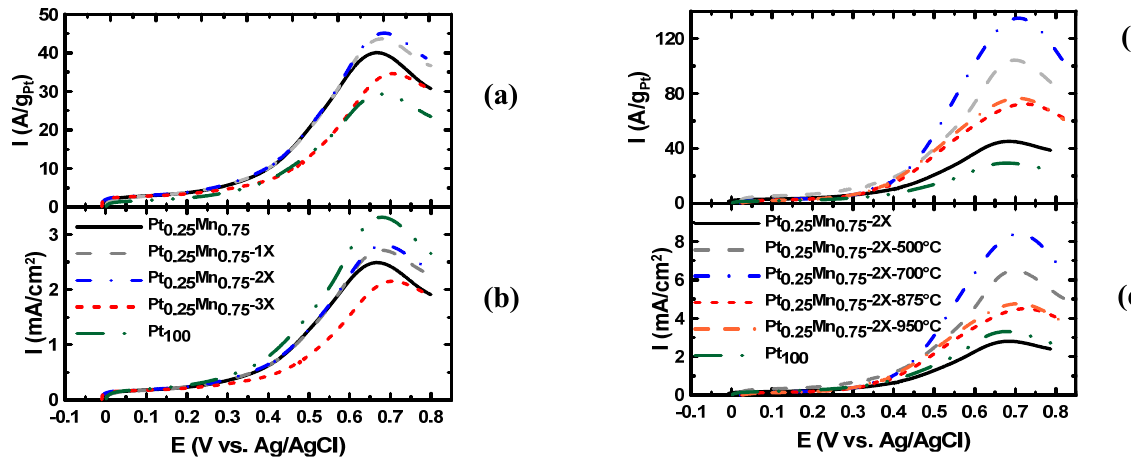
Figure 11. Linear sweep voltammetry (LSV) in the 0.5 M H 2 SO 4 + 0.1 M ethanol solution at a scan rate of 20 mV/s for: ( a ) the samples prepared with different sodium citrate contents; ( c ) the sample produced with 2X sodium citrate content and heat treated at different temperatures. ( b ) The same as ( d ), normalized for platinum content of ( a ) and ( d ), respectively.